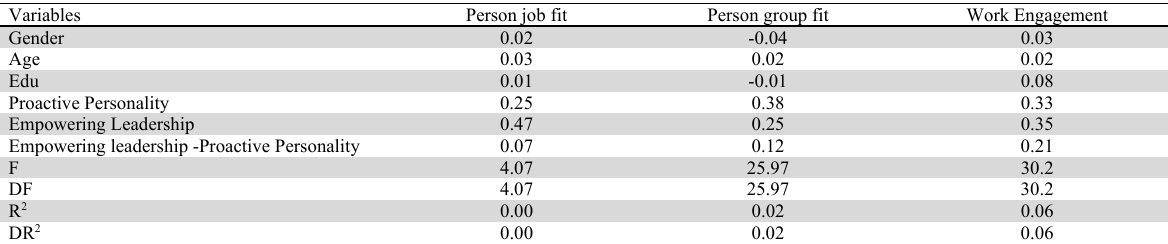
Moderation Effects.